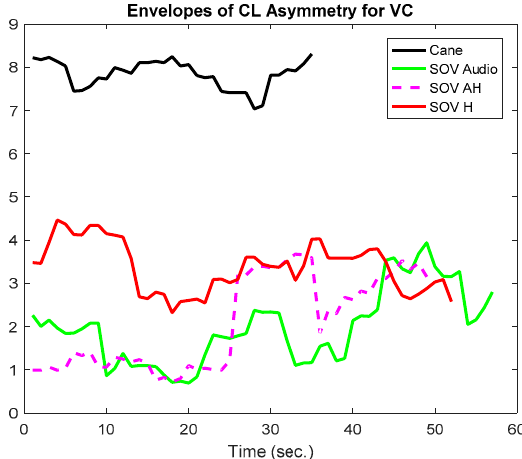
Figure 26. Visual cortex asymmetry for UserA (early-blind). Sensors 2020 , 20 , x FOR PEER REVIEW